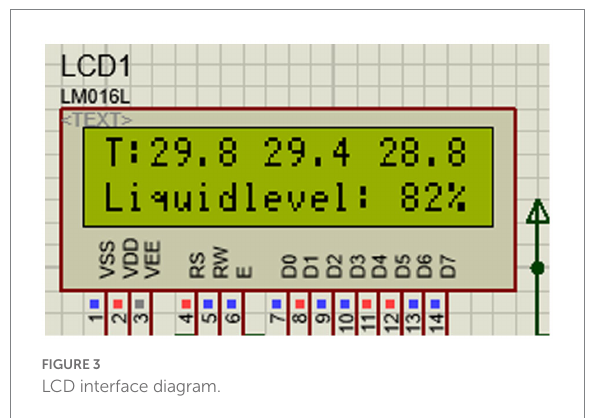
FIGURE 3 LCD interface